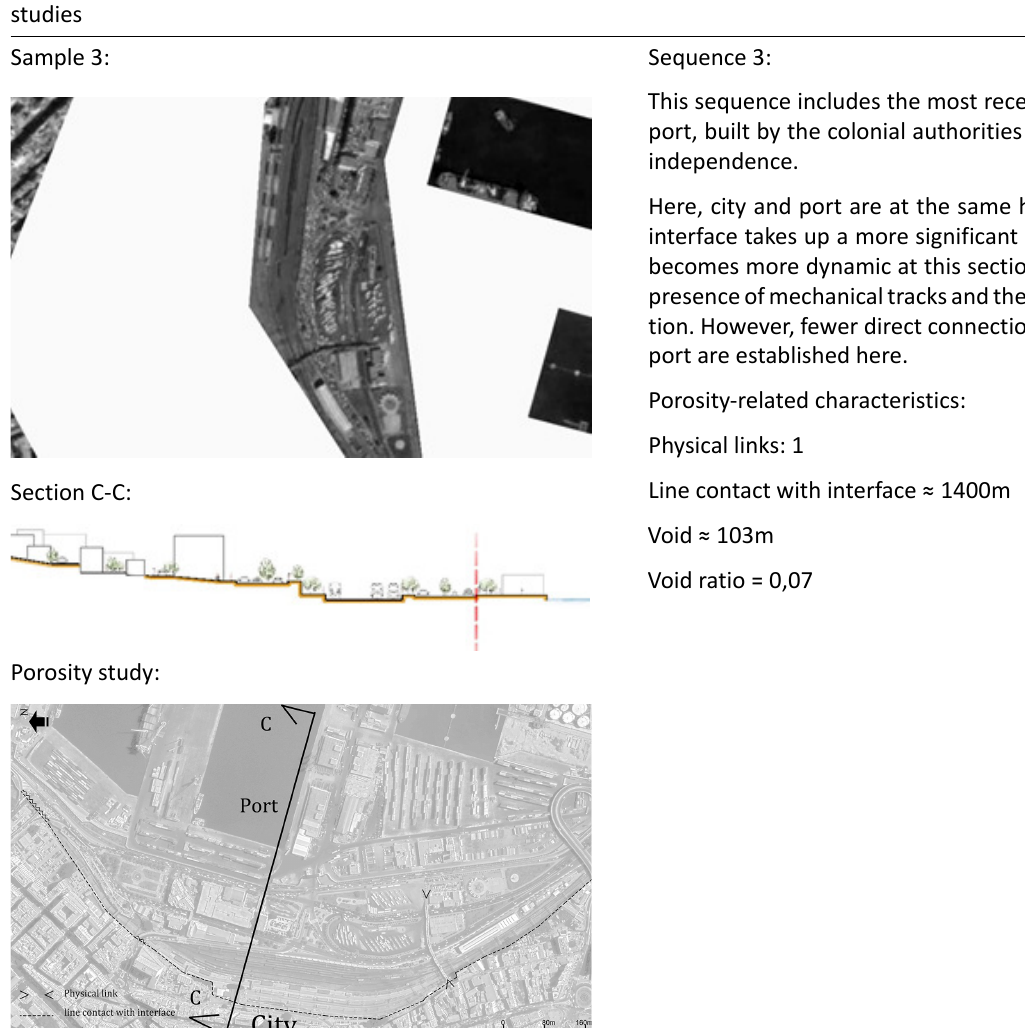
Table 1. (Cont.) Different sequences of Algiers’ current port‐city interface. Satellite views with schematic cross‐sections and